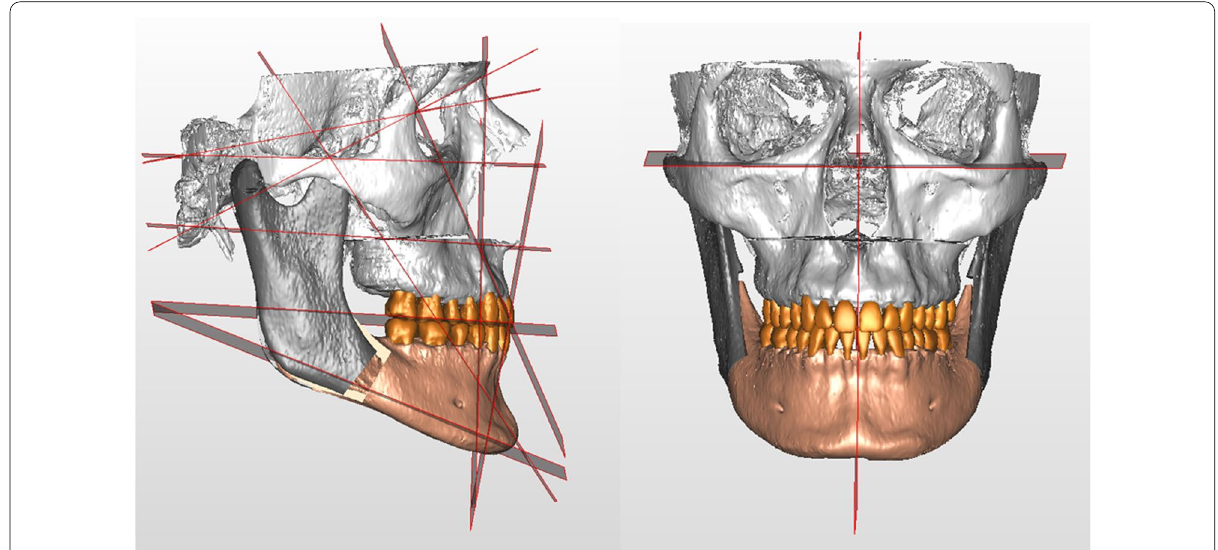
Fig. 2 Example of cephalometric reference planes in a VOSP representation